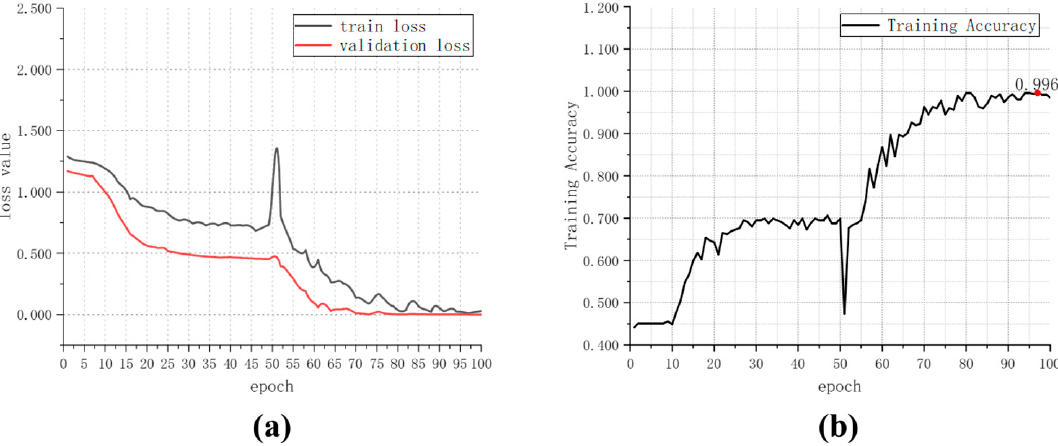
Figure 9. Loss curve and training accuracy curve of VGG16.In ( a ), when epoch > 80,the training loss and validation loss are both stable. In ( b ), the training accuracy reaches 99.6% at epoch 97 (the accuracy also reaches 99.6% at epoch 80 and epoch 81).